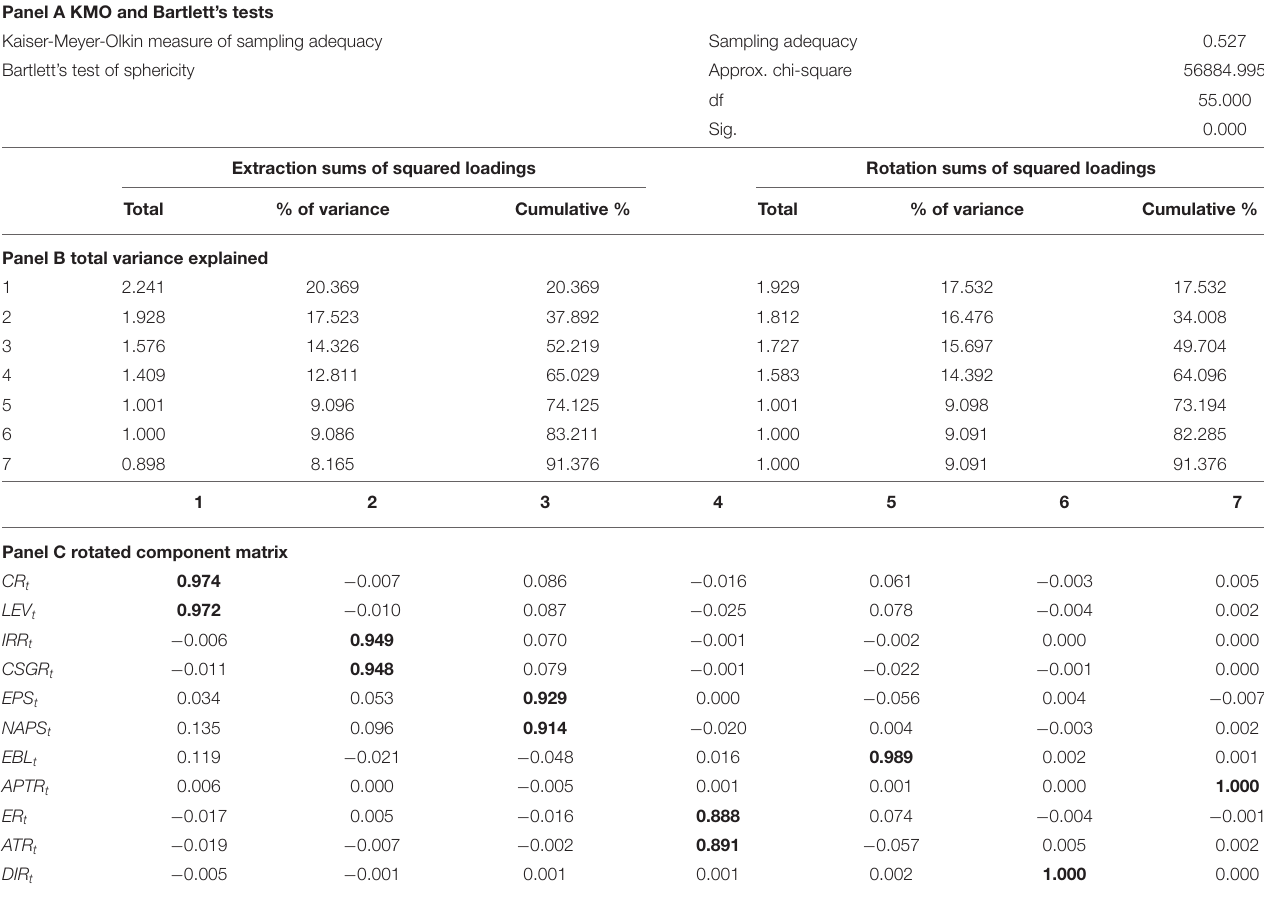
TABLE 1 | Factor analysis: measuring firm CSR performance. Panel A KMO and Bartlett’s tests